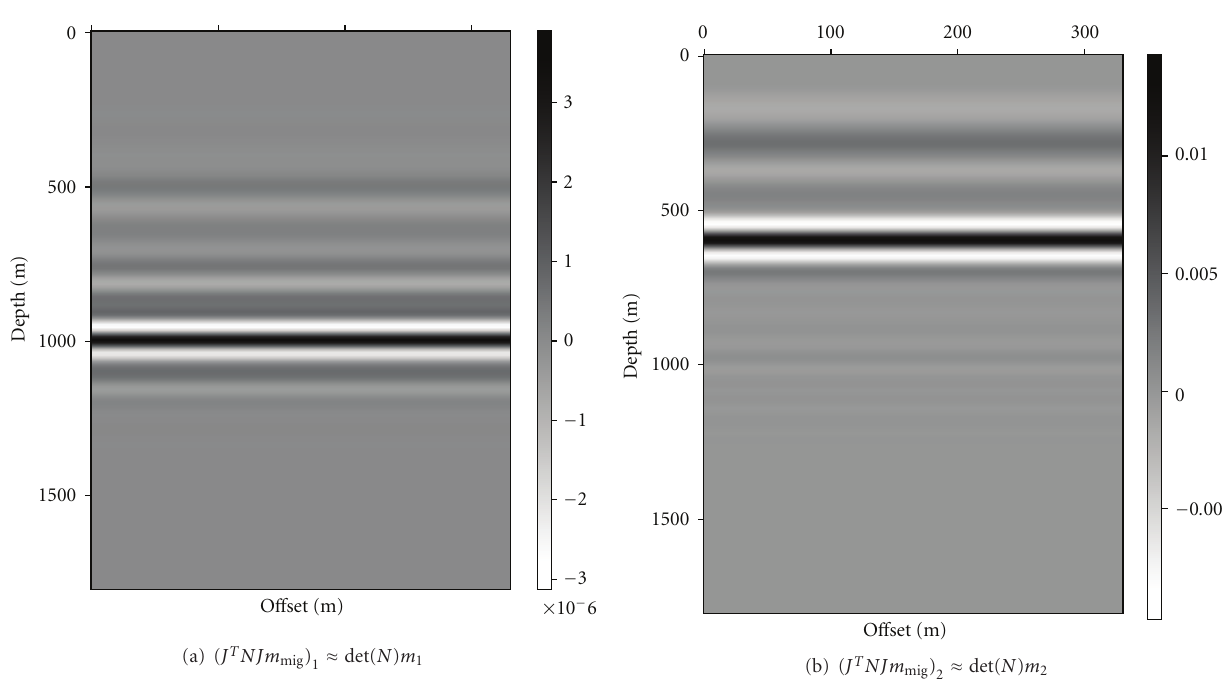
Figure 4: The application of the adjugate separates the velocity and density contributions. This result is a phase space scaling of the true